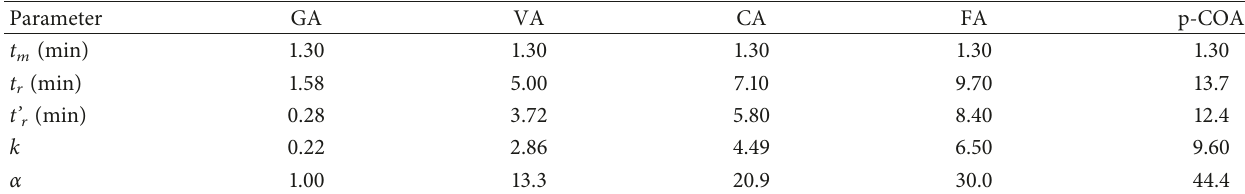
Table 1: Chromatographic parameters for separation of polyphenols a .